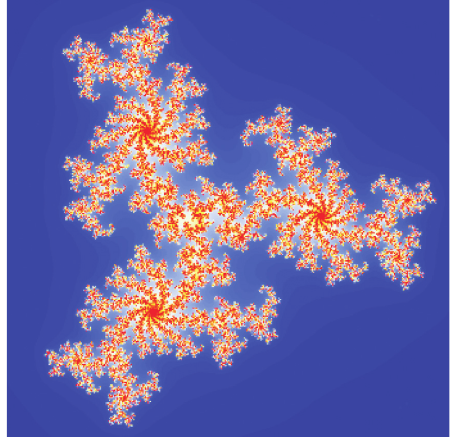
Figure 7: Cubic Julia set in JSOmhh.